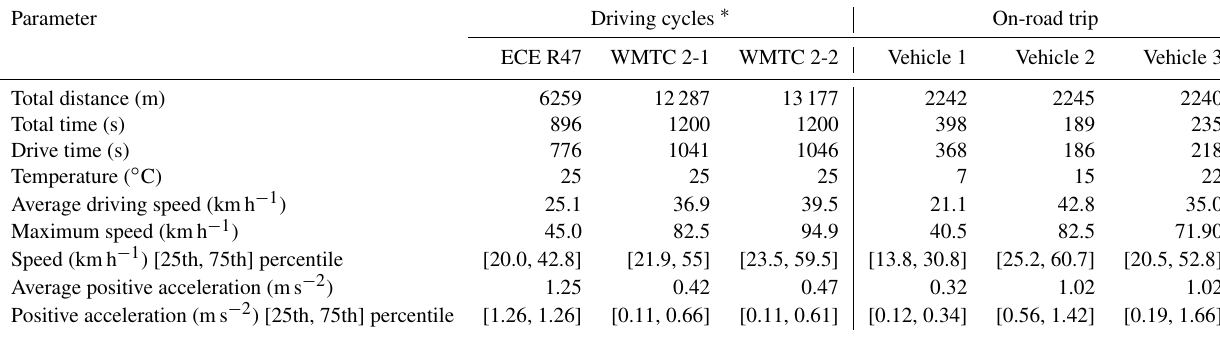
Table 2. Roller bench driving cycles and on-road trip parameters. Notes: